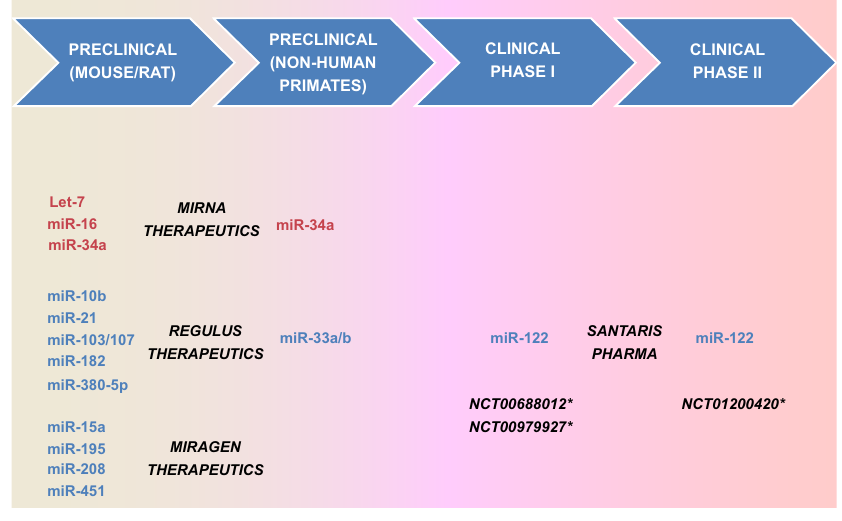
Figure 1. Leading companies developing microRNA therapeutics. The four stages at the top denote the progress of individual miRNA drugs. Red colored miRNAs indicate replacement therapy with drug mimicking the endogenous miRNA. Blue colored miRNAs indicate inhibition therapy with drug targeting the endogenous miRNA. *Santaris Pharma has completed two Phase I clinical trials and is currently in Phase II with their miR-122 targeting drug